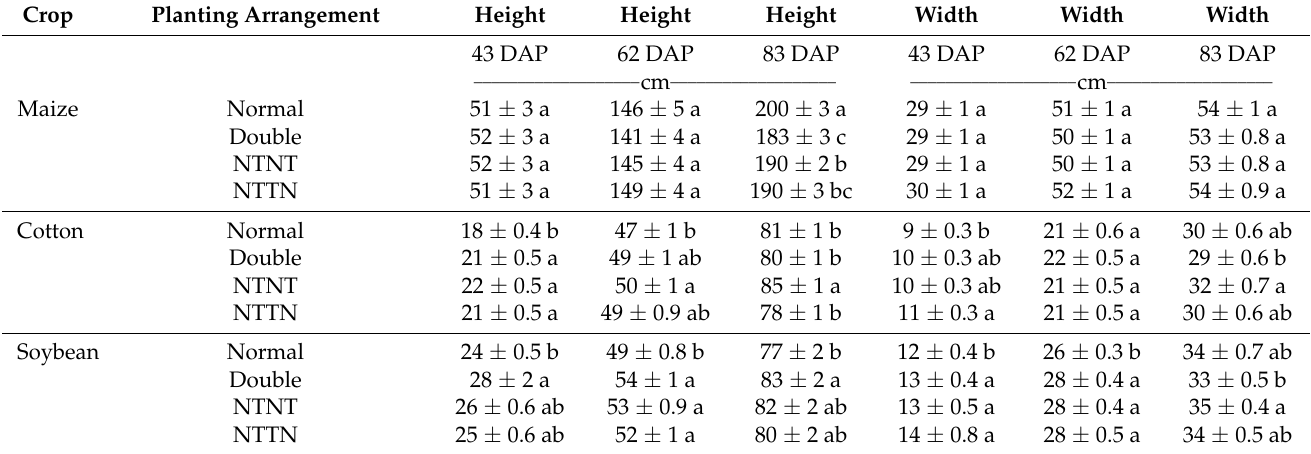
Table 2. Height and width for maize, cotton, and soybean for each planting arrangement. NTNT: a sequential arrangement of normal and tripled densities (each in every other row), and NTTN: normal-tripled-tripled-normal planting density. Means and standard error of the means followed by a different letter indicate significant differences at p < 0.05.